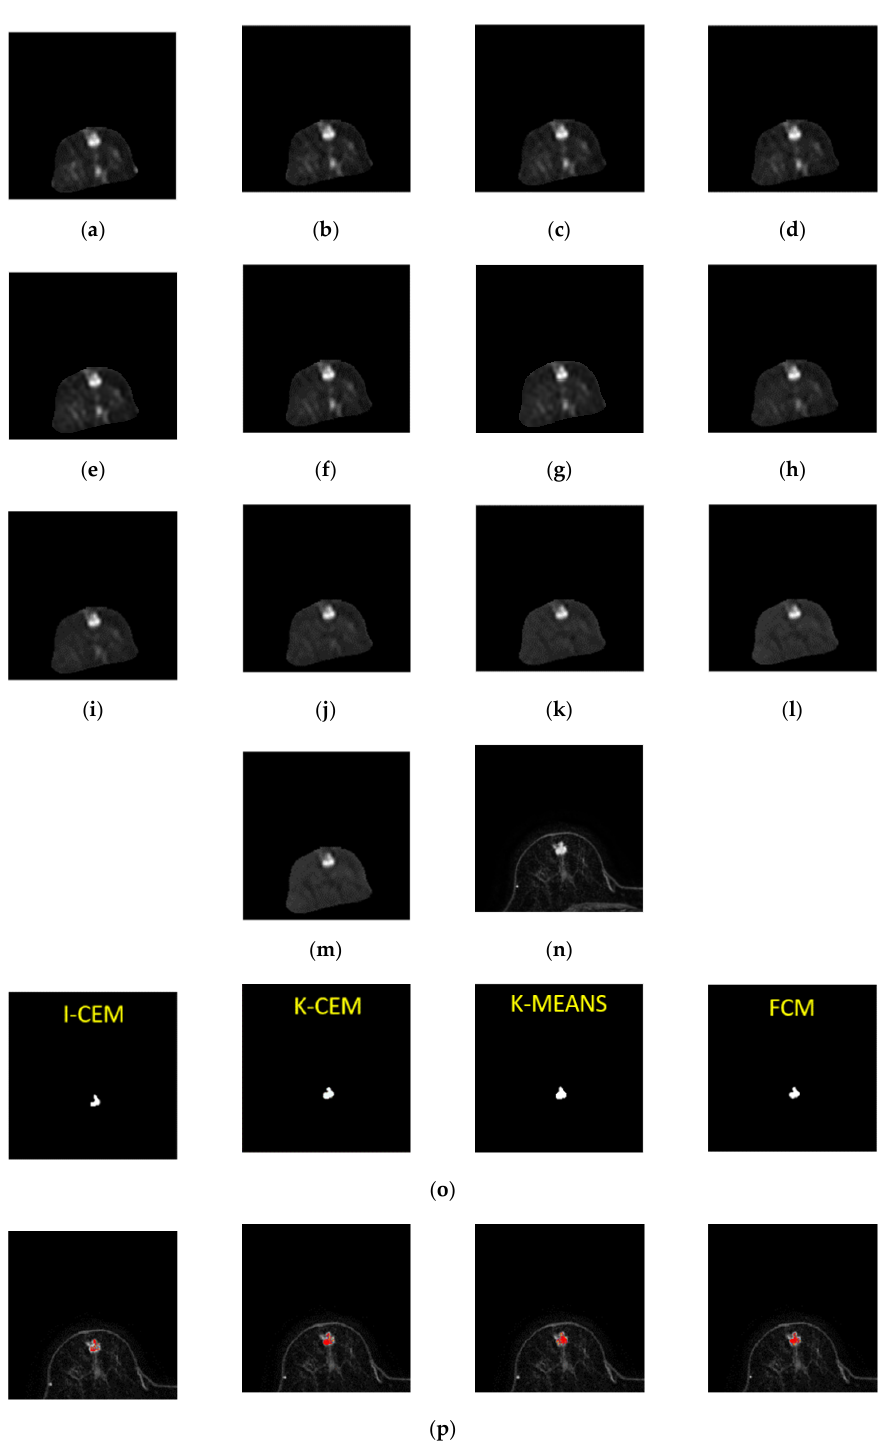
Figure 9. Third-slice IVIM-DW images of a mass tumor with b values of ( a ) 0, ( b ) 15, ( c ) 30, ( d ) 45, ( e ) 60, ( f ) 100, ( g ) 200, ( h ) 400, ( i ) 600, ( j ) 1000, ( k ) 1500, ( l ) 2000, and ( m ) 2500 s/mm 2 . ( n ) Dynamic contrast-enhanced T1-MR imaging. ( o ) Tumor detection results obtained via I-CEM, K-CEM, K- means, and FCM. ( p ) Tumors detected via the four methods (left-to-right: I-CEM, K-CEM, K-means, and FCM) mapped onto a dynamic contrast-enhanced T1-MR